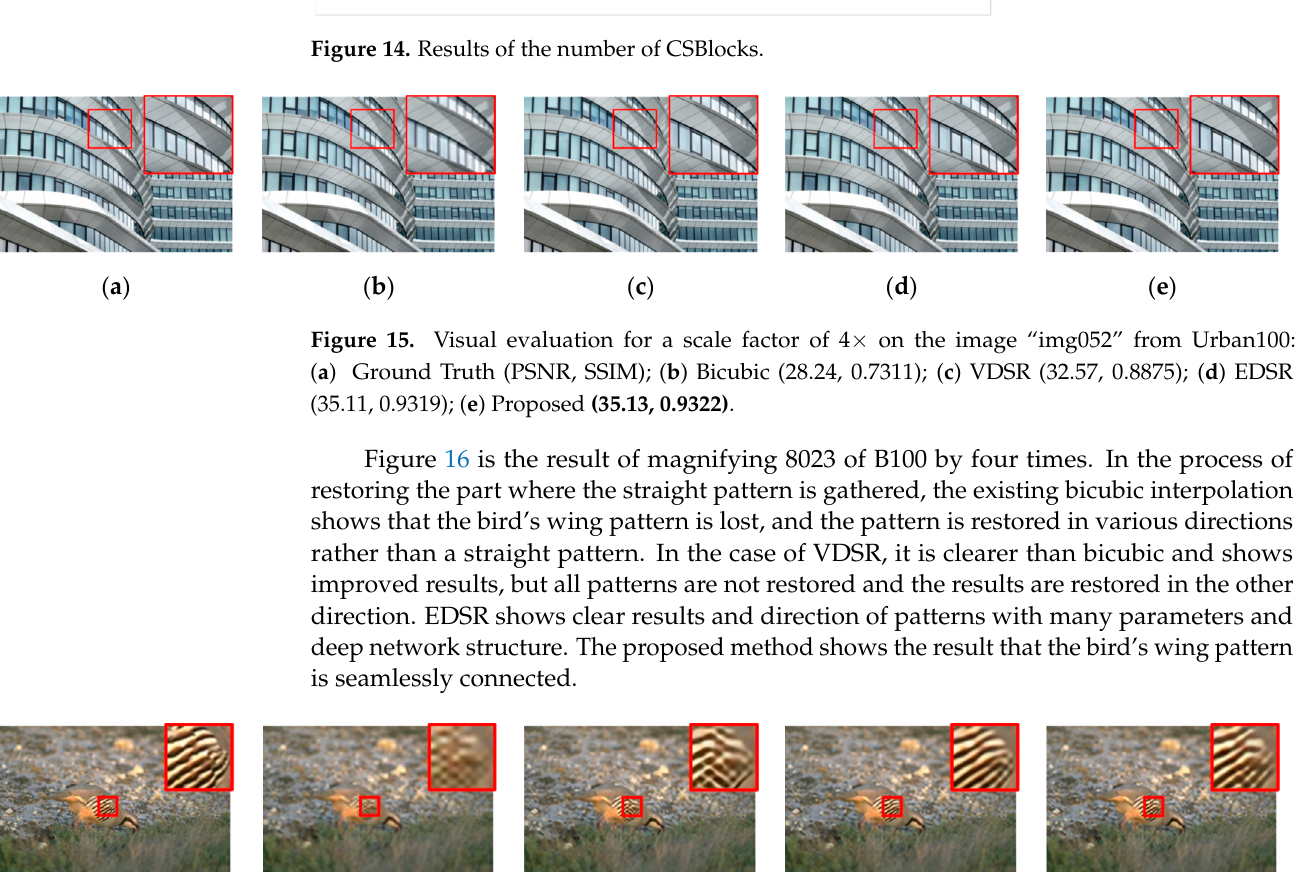
( e ) Figure 17. Visual evaluation for a scale factor of 4× on the image “PPT3” from Set14: ( a ) Ground Truth (PSNR, SSIM); ( b ) Bicubic (24.31, 0.7889); ( c ) VDSR (29.93, 0.9344); ( d ) EDSR (31.51, 0.9594); ( e ) Proposed (31.53, 0.9593) . Figure 18 is the result of magnifying the COMIC of Set14 by four times. Bicubic in- terpolation has blurred outlines due to complex and small patterns, and the small patterns have disappeared. VDSR is improved over bicubic interpolation in the small missing pat- terns of objects, but the outlines are blurry. EDSR contours have been improved and object behavior has been restored. The proposed method has improved contour lines and shows good numerical results. ( a )